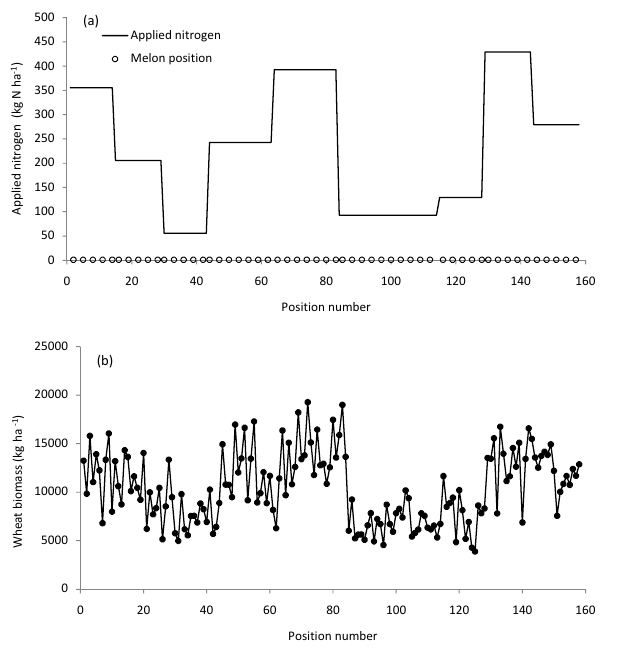
Fig. 4. (a) Applied nitrogen (kg N ha − 1 ) plotted against position. The location of the melon rows are shown by the symbol o. (b) The wheat biomass (kg ha − 1 ) plotted against position.